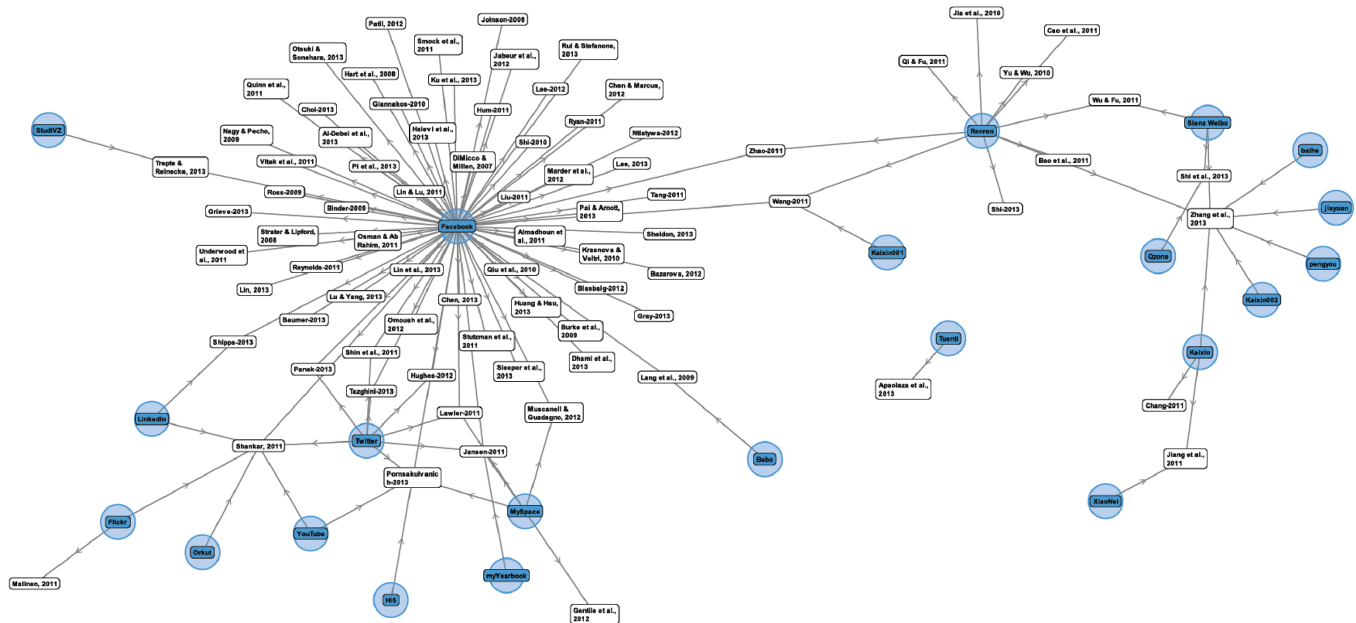
Fig 5. Clusters of Social Networking Sites and associated